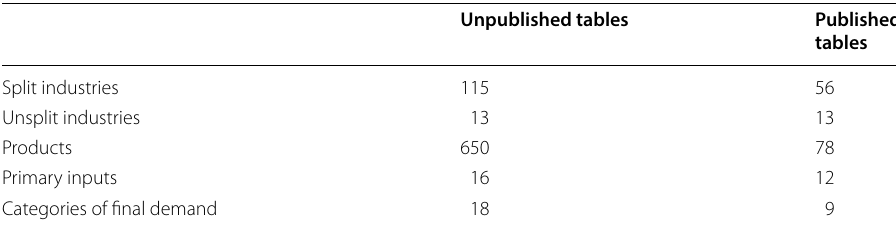
Table 1 Detail of SUT and